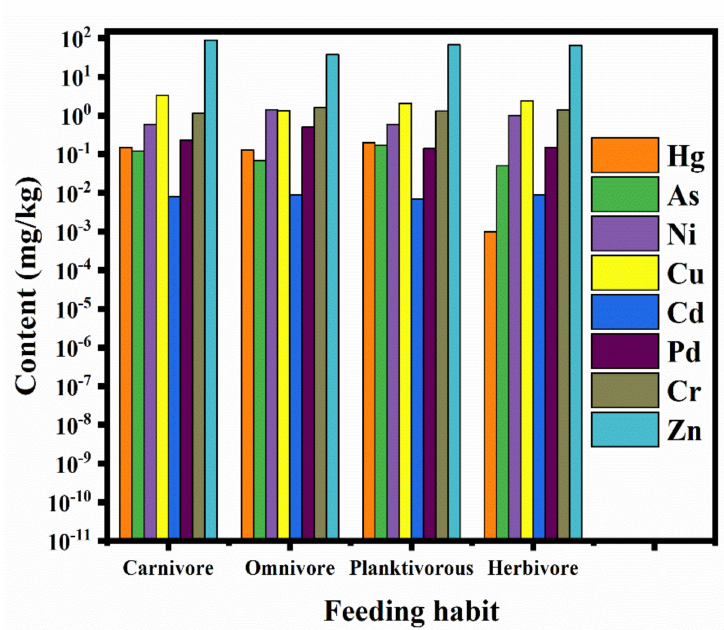
Figure 2. Trace metal contents of fish with different